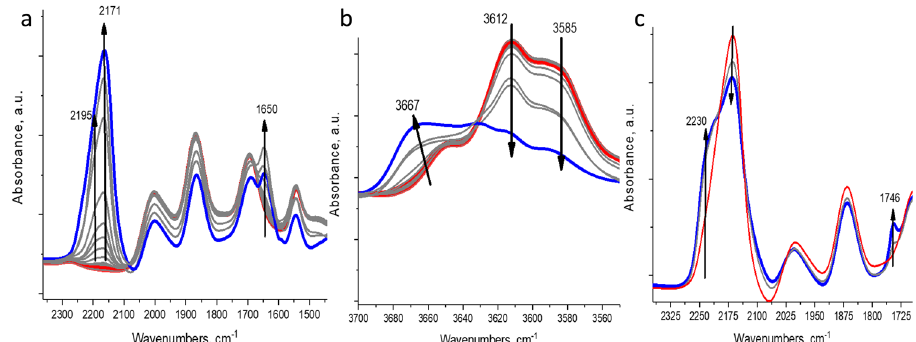
Fig. 1 Monitoring NxOy species in H-SSZ-13 with FTIR. a In-situ FTIR NO stretching region during sequential NO 2 adsorption (2 Torr) on H-SSZ-13 with Si/Al ~12. The b OH stretching region during the process is described in A. c Adsorption of excess NO 2 (2 Torr) on NO 2 -saturated sample in A. IR cell vacuum was used as background (not zeolite itself) in a , b , and c